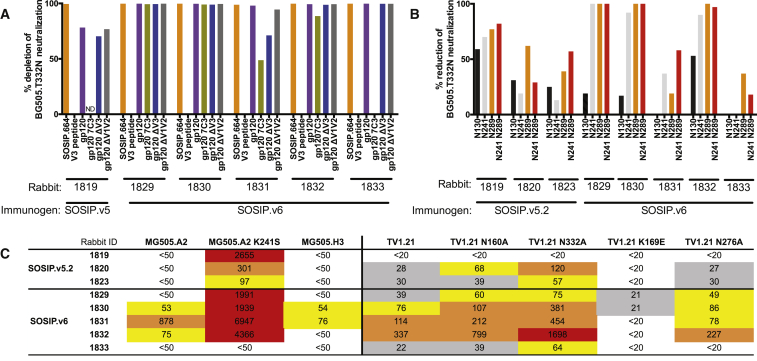
Properties of the Autologous NAb Specificities(A) Neutralization depletion assays with sera from one BG505 SOSIP.v5.2 recipient and all five BG505 SOSIP.v6-immunized animals using the autologous BG505.T332N virus and a BG505 V3 peptide, as well as a set of different BG505 proteins. Neutralization of BG505.T332N from each individual sera was set at 100%, and the percent depletion was calculated when the V3 peptide or the different BG505 proteins were added in the assay. The percentage shown is the mean of two different experiments.(B) Neutralization assays with BG505.T332N PNGS mutants. The ID50 of the individual sera with the parental BG505.T332N virus was set at 100%, and the percent reduction in ID50 when the respective PNGSs are introduced is shown. See also Table S4B.(C) Neutralization of maternal MG505 viruses and heterologous TV1.21 mutant viruses. The ID50s are shown. Strong neutralization (ID50 > 1,000) is shown in red; 1,000 > ID50 > 100 is shown in orange; 100 > ID50 > 50 is shown in yellow, and no neutralization (ID50 < 50) is shown in white.